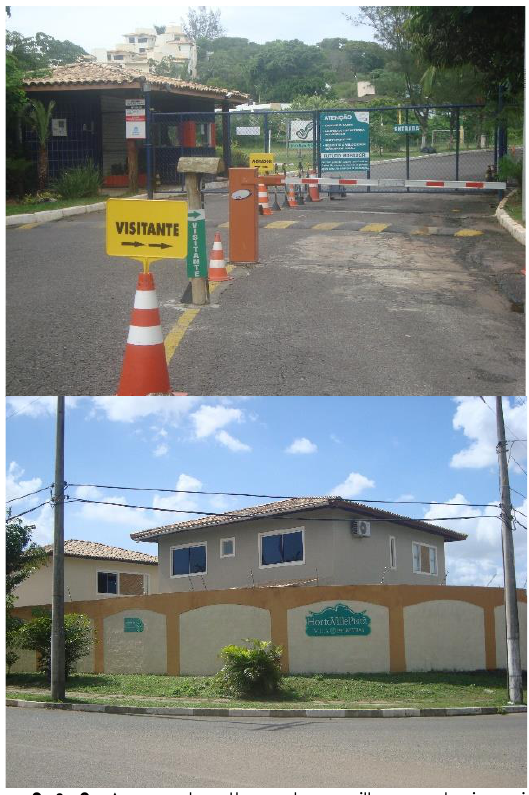
Figure 8 & 9. Access booth and surveillance devices in Salvador de Bahía, Brazil (Gómez y Arantes, 2016. Gómez y Arantes,